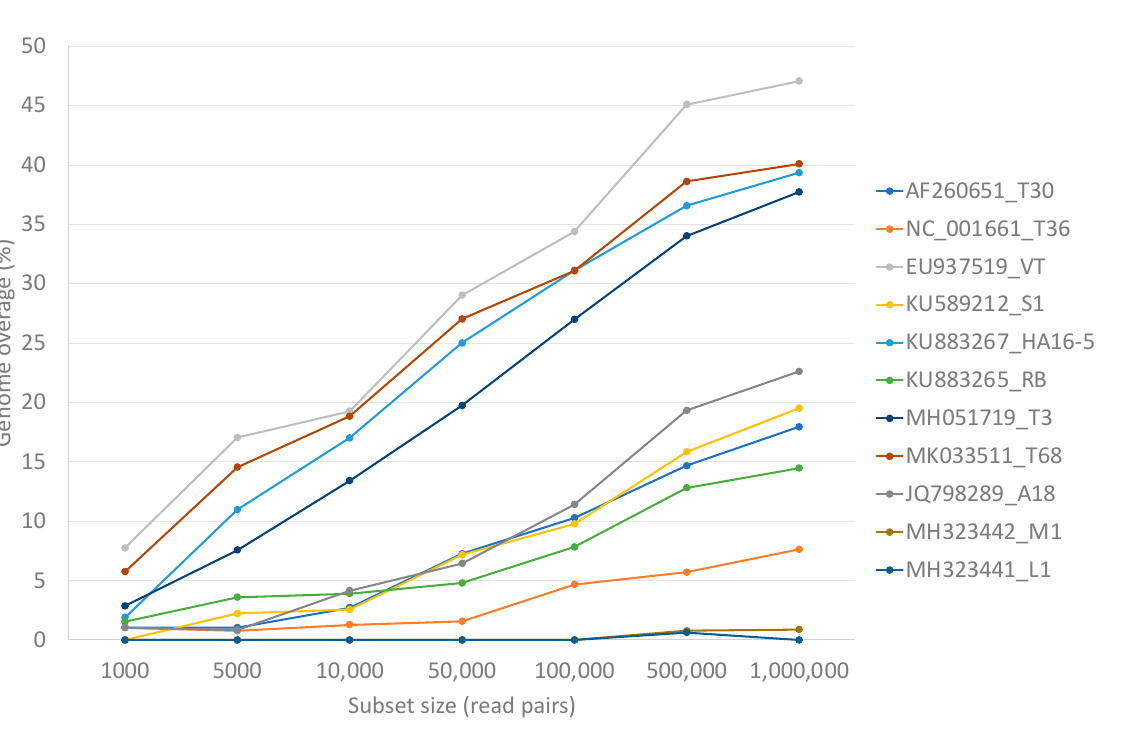
Figure 5. A line graph displaying the non-target genome coverage per representative genotype after read mapping equal numbers of read pairs of each of the other 10 genotype-specific data sets. The number of read pairs per genotype-specific data set was increased to illustrate the influence of sequencing depth on the expected non-target genome coverage.